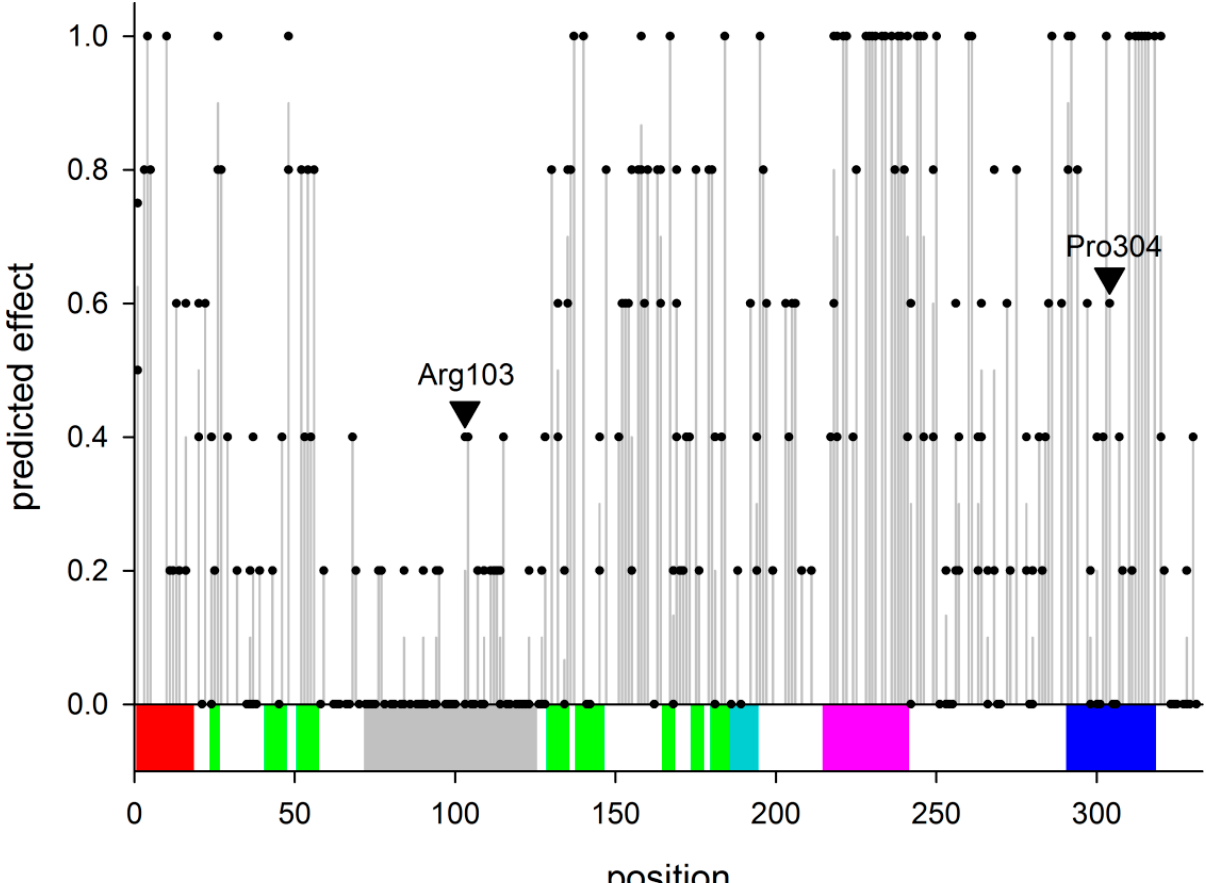
Figure 2. Predicted effect of mutations in hNEIL2. Black dots indicate the effect of any given variant at a particular position (Table S1). Grey bars indicate the average effect of all known polymorphisms at a particular position. Arrowheads mark the positions of R103W and P304T variants. The colored bar below corresponds to the main elements of the hNEIL2 structure as inferred based on sequence homology with oNEIL2 and mvNEIL2/3: red, the N-terminal α -helix carrying the catalytic Pro and Glu; green, β -sandwich in the N-terminal domain; grey, the disordered loop; turquoise, the interdomain linker; magenta, the H2TH motif; blue, the zinc finger.